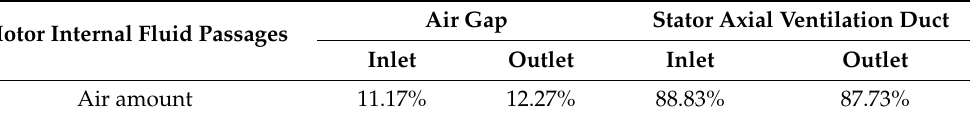
Table 4. The air amount in the motor.